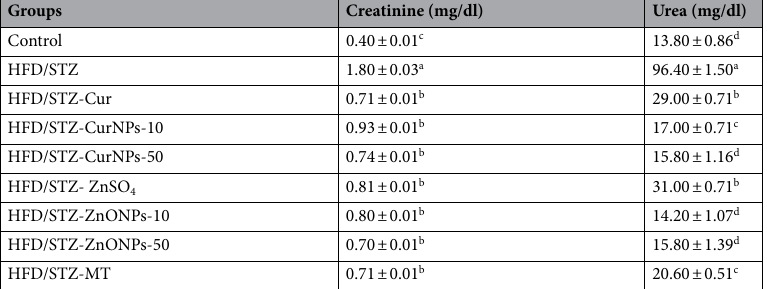
Table 6. Effect of CurNPs and ZnONPs administration on serum kidney profile (creatinine and urea) of STZ- induced diabetic and control rats. Values are expressed as mean ± SEM (n = 7), means for the same parameter with different letters in each column are significantly different (Tukey, p <